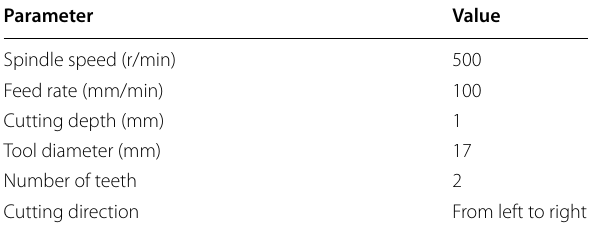
From left to right